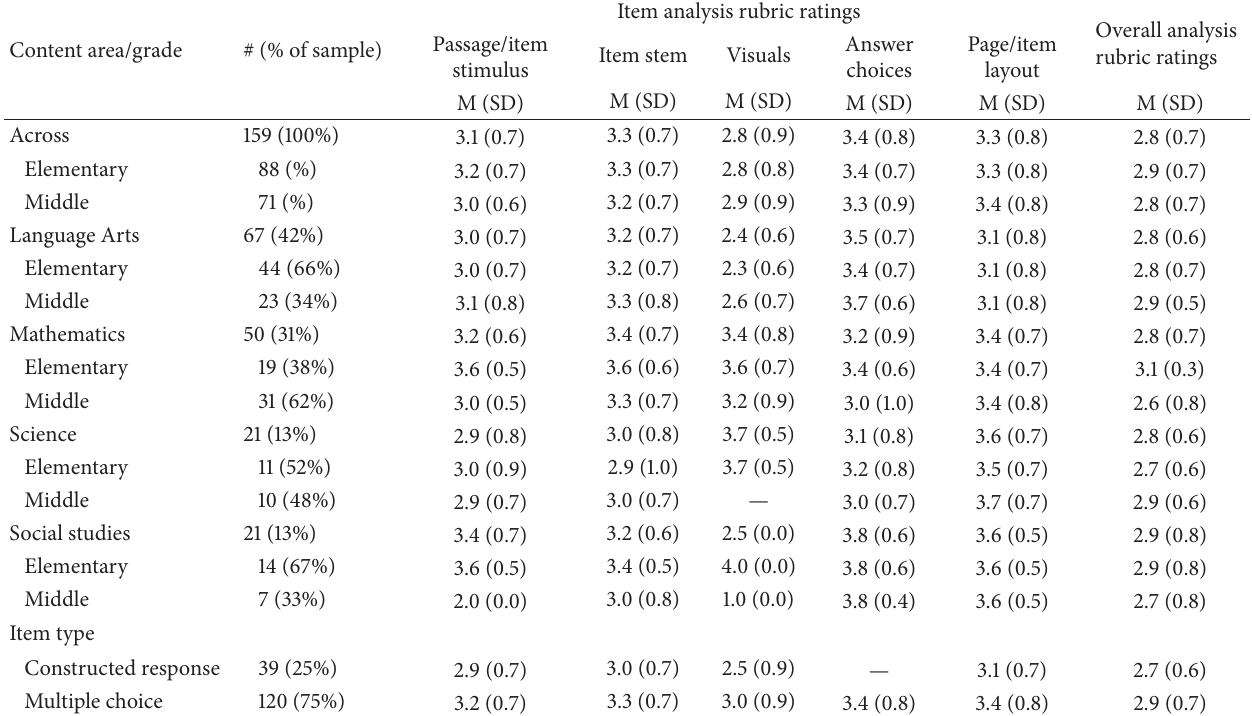
Table 2: Accessibility ratings by grade, content area, and item type for state